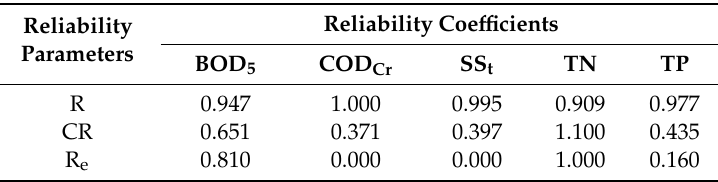
Table 4. The values of the wastewater treatment plant operation work reliability coe ffi cients determined based on the Monte Carlo simulation